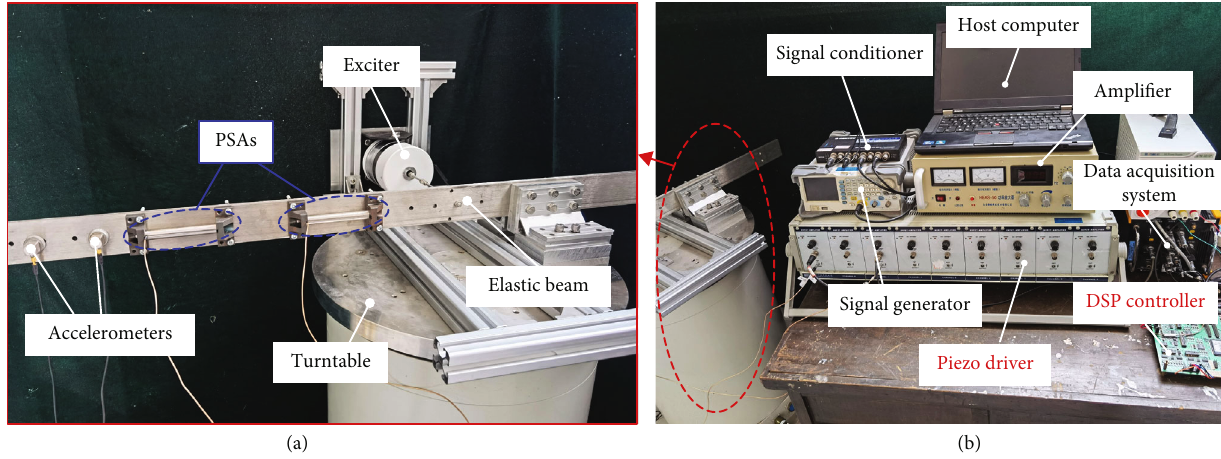
Figure 10: Physical diagram of the elastic beam rotary ACSR experiment system. (a) Elastic beam rotary test bench. (b) Measurement and control system.